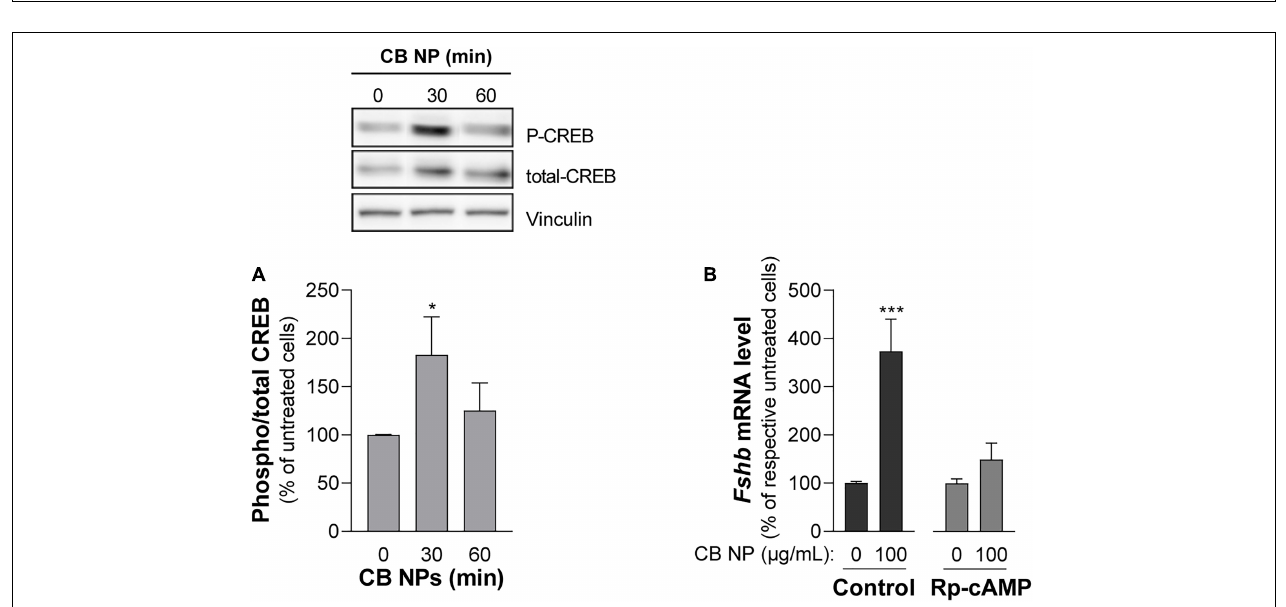
FIGURE 6 | Role of the cAMP pathway in the effects of CB NPs on Fshb expression in L β T2 cells. (A) L β T2 cells were cultured for the indicated time with 100 µ g/mL of CB NPs. Phospho-CREB and total CREB protein levels were analyzed by immunoblotting. Phospho-CREB protein levels were normalized by total CREB signals (histogram) and expressed as percentage over untreated cells. There was no significant alteration of total CREB content after CB NP treatment as assessed by normalization with vinculin (total CREB/vinculin ratio was of 145 ± 21% and 142 ± 20% of control at 30 and 60 min, respectively, p > 0.05). Data are the mean ± SEM of 4 or 5 independent experiments. Statistical differences were determined by non-parametric Kruskal-Wallis test followed by Dunnet’s multiple comparison test. * p < 0.05 compared to no CB NPs. (B) L β T2 cells were cultured for 24 h with or without 100 µ g/mL of CB NPs and PKA inhibitor, Rp-cAMP (100 µ M). Total RNAs were extracted and Fshb mRNA levels were determined by real-time quantitative PCR. Data are expressed as percentage over control untreated cells (0 CB NPs) and are the mean ± SEM of 8 independent experiments. Basal Fshb mRNA levels were not significantly affected by treatment with the PKA inhibitors. Statistical differences were determined by the Mann-Whitney test. *** p < 0.001 compared to respective untreated